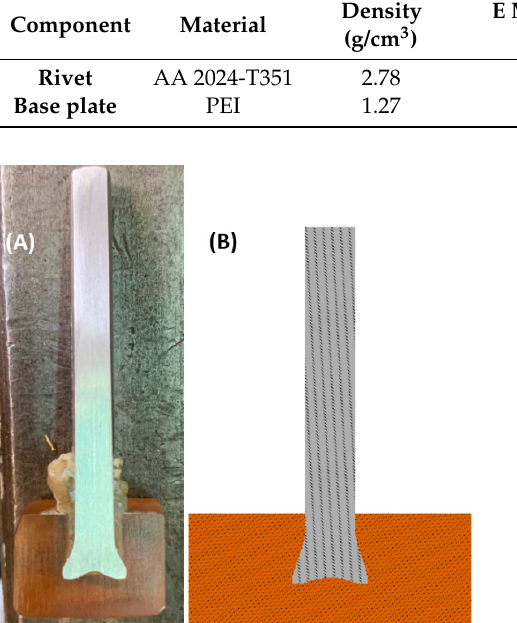
Figure 5. Friction riveted joint ( A ) cross section and ( B ) FE model.